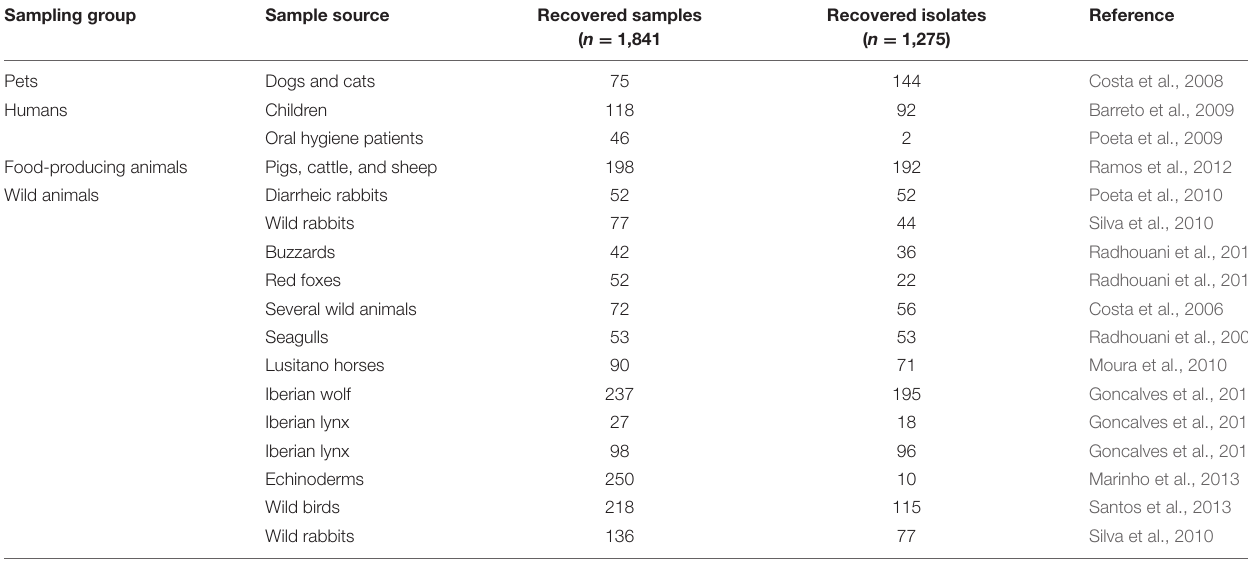
TABLE 1 | Description of all sources of Escherichia coli isolates analyzed in a decade of antimicrobial resistance (AMR) surveillance in Portugal by the UTAD Functional Genomics and Proteomics Unit. Sampling group